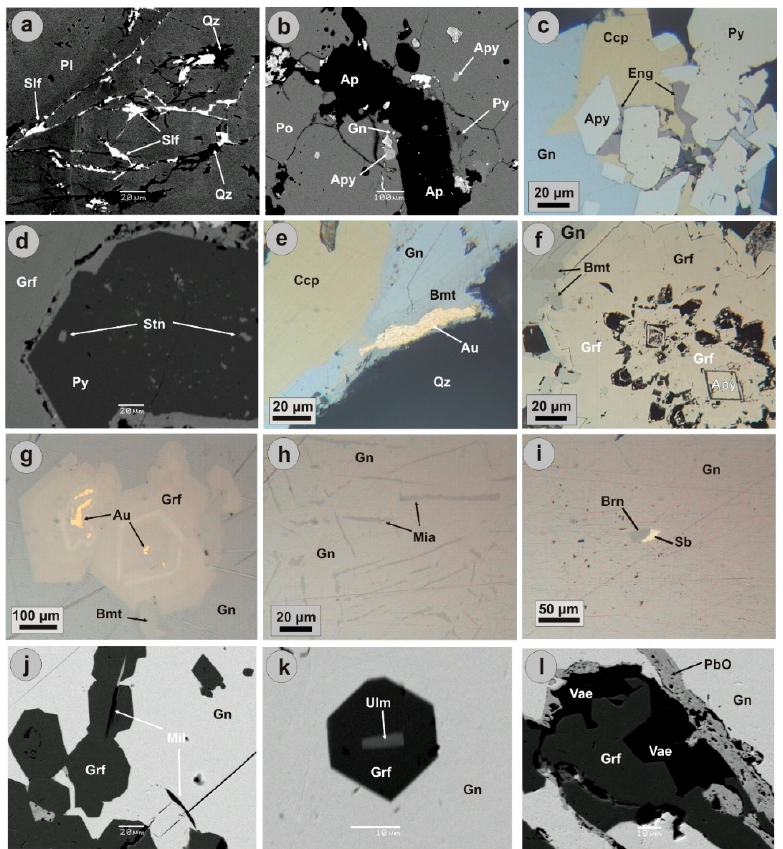
Figure 5. Photomicrographs of the ore parageneses in the Serpieri, Clemence, and “km3” areas. ( a ) Sulfides (slf) and quartz (Qz) filling fissures in plagioclase (Pl) (KA1, SEM-BSE image, microgranite, Serpieri); ( b ) pyrrhotite (Po) including arsenopyrite (Apy), pyrite (Py), and galena (Gn). Apatite (Ap) is also present (KA1, SEM-BSE image, microgranite, Serpieri); ( c ) pyrite and arsenopyrite formed first and were followed by chalcopyrite (Ccp), and enargite (Eng), and then by galena (CLM2, reflected light, plane polarized, Clemence); ( d ) pyrite with inclusions of stannite (Stn) is surrounded by gersdorffite (Grf) (CLM6a, scanning electron microscope-backscattered image, Clemence); ( e ) chalcopyrite rimmed by galena and bismuthinite (Bmt), and native gold (Au). Quartz (Qz) is gangue mineral (CLM6, reflected light, plane polarized, Clemence); ( f ) arsenopyrite rimmed by gersdorffite, the latter surrounded by bismuthinite and galena (CLM6b, reflected light, plane polarized, Clemence); ( g ) oscillatory zoned gersdorffite containing native gold and bismuthinite surrounded by galena (CLM6b, reflected light, plane polarized, Clemence); ( h ) miargyrite (Mia) as exsolution lamellae within galena (CLM4a, reflected light, plane polarized, Clemence); ( i ) bournonite (Brn) and native antimony (Sb) included in galena (CLM6a, reflected light, plane polarized, Clemence); ( j ) millerite (Mil) needles included in gersdorffite and galena (scanning electron microscope-backscattered electron image, “km3”); ( k ) ullmannite (Ulm) enclosed in gersdorffite (scanning electron microscope-backscattered image, “km3”); ( l ) gersdorffite surrounded by vaesite (Vae), enclosed in galena (Gn) (scanning electron microscope-backscattered image, “km3”).